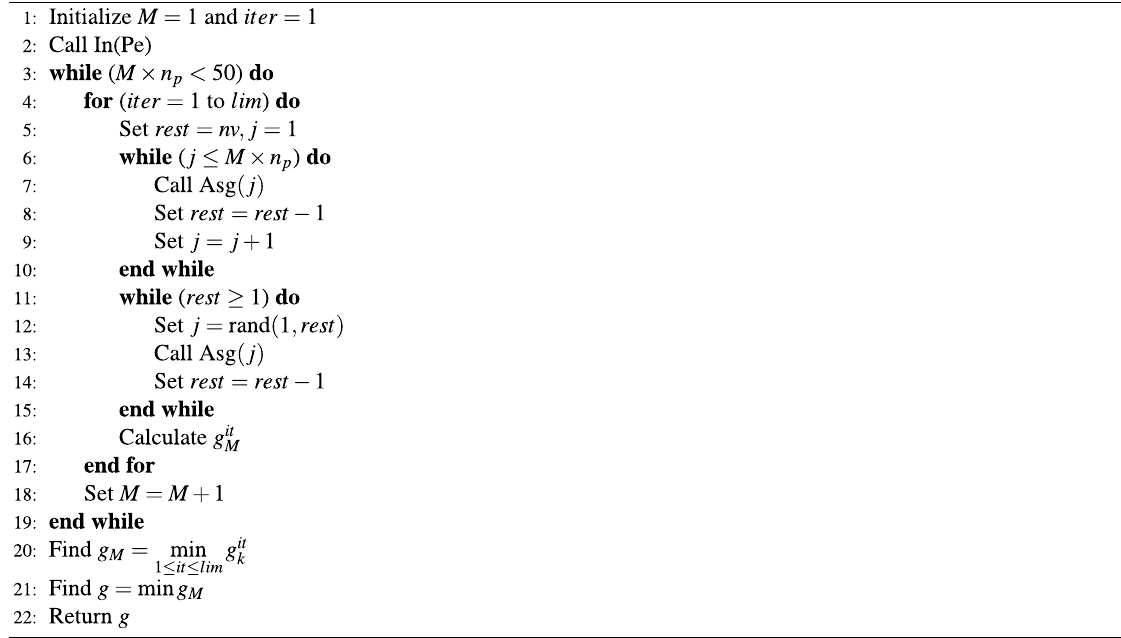
Table 3. M-vehicles with NI and random choice algorithm (NR).